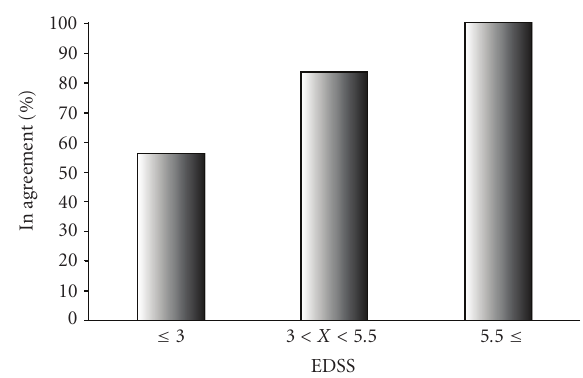
Figure 3: Association between patients disability and interest in Internet information on coping strategies of other patients. Patient disability groups are defined by EDSS range ( x -axis). The percentage of respondents that agreed with the sentence: “I would be happy to read about how other patients cope with MS” is indicated by % of in agreement. ( P for Trend = . 01, response rate >